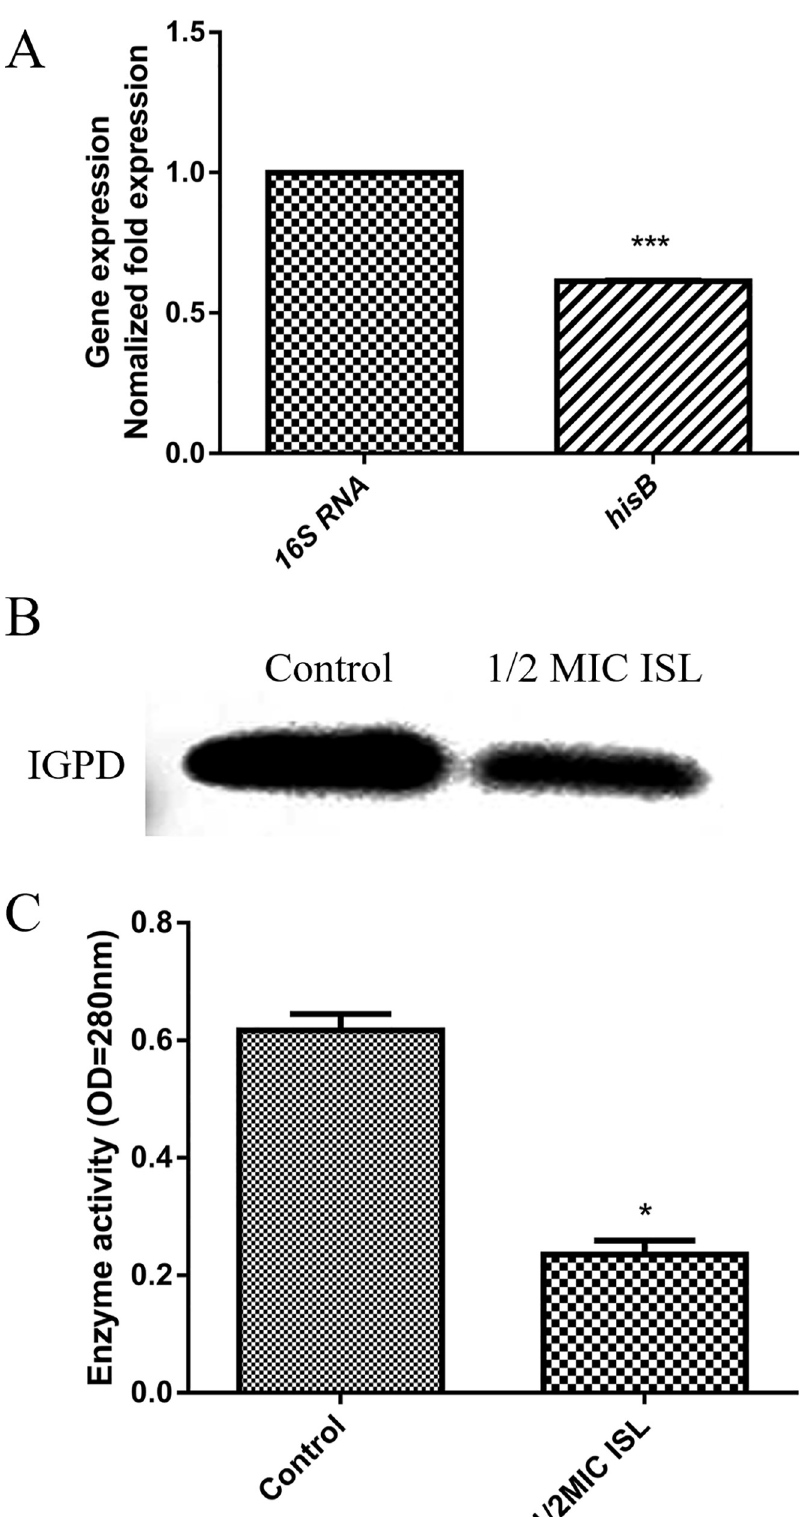
Fig 4. Regulation of S . xylosus IGPD by ISL. (A) Effect of 1/2MIC of ISL on mRNA expression of hisB gene in S . xylosus . Data are expressed as means ± SDs. Significantly different means are indicated with asterisks ( � ) compared